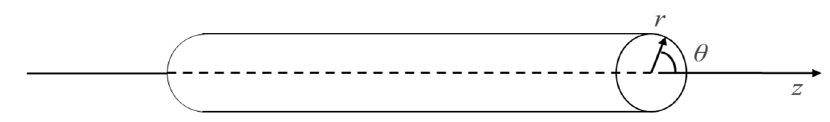
Figure 1. Infinitely long cylindrical rod with diameter of r.